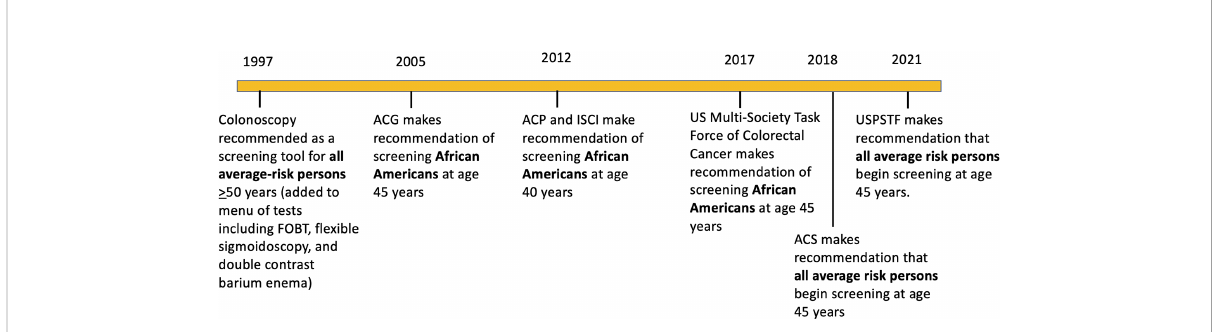
FIGURE 1 Timeline of colorectal screening recommendations for average risk persons and African Americans over the past 3 decades by various organizations (2, 9). ACG: American College of Gastroenterology; ACP, American College of Physicians; ICSI, Institute for Clinical Systems Improvement; ACS, American Cancer Society; USPSTF United States Preventative Services Task